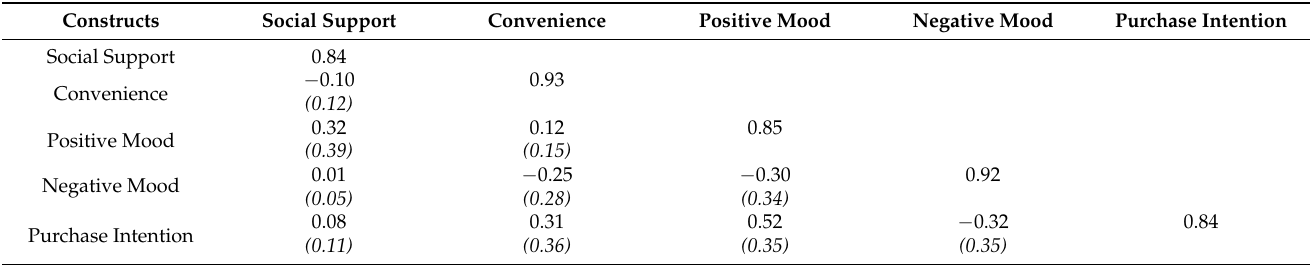
Table A2. Discriminant validity results for Agreeableness group.